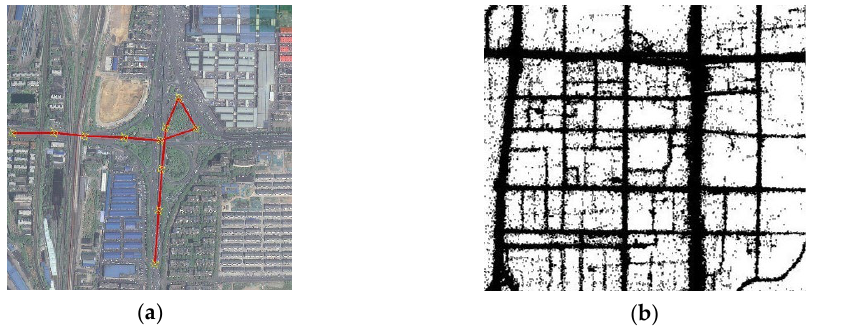
Figure 1. Spatio-temporal heterogeneities and uneven density distribution of crowdsourced trajectory data: ( a ) inconsistent trajectory shape and ( b ) varied trajectory densities.